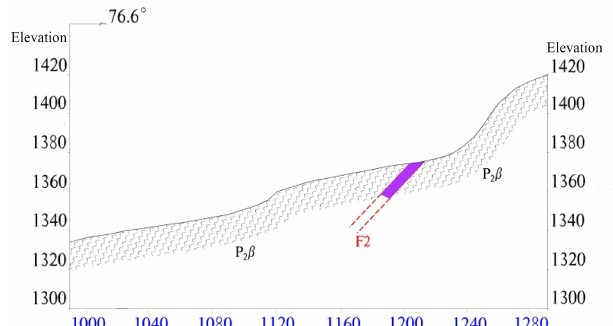
Figure 20. Geological profile of mining area.